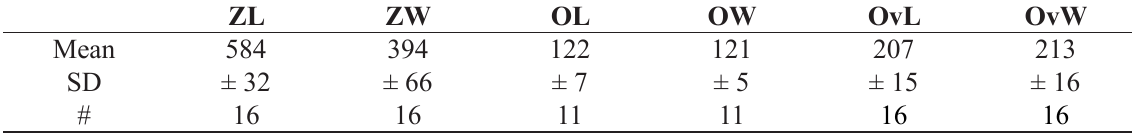
Table 6. Measurements of Atlantisina tricornis gen. et sp. nov. from Galicia Bank population GAL1. ZL ZW